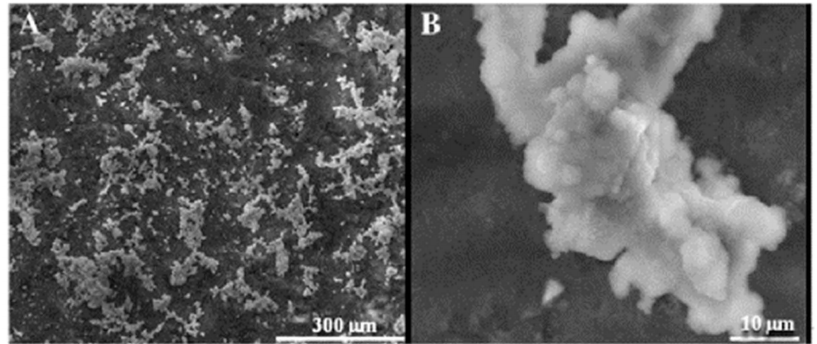
Figure 15. ( A ) SEM micrographs of the GEO-TA’ sample after soaking in SBF for 21 days and ( B ) detail at high resolution of a hydroxyl-apatite crystal formed on the geopolymer sample [121].